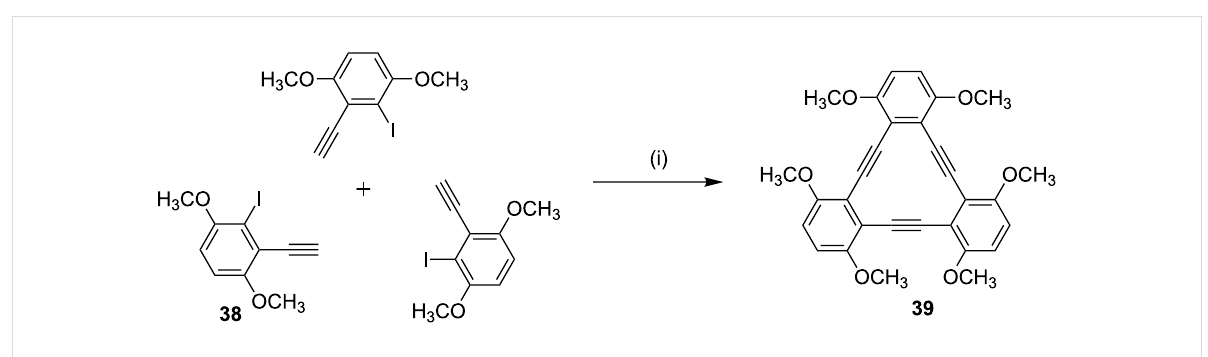
Scheme 4: Synthesis of tribenzocyclotriyne 39 through Castro–Stephens coupling reaction. Reagents and conditions: (i) CuCl/ NH 4 OH/EtOH, pyri- dine, reflux, 24 h,